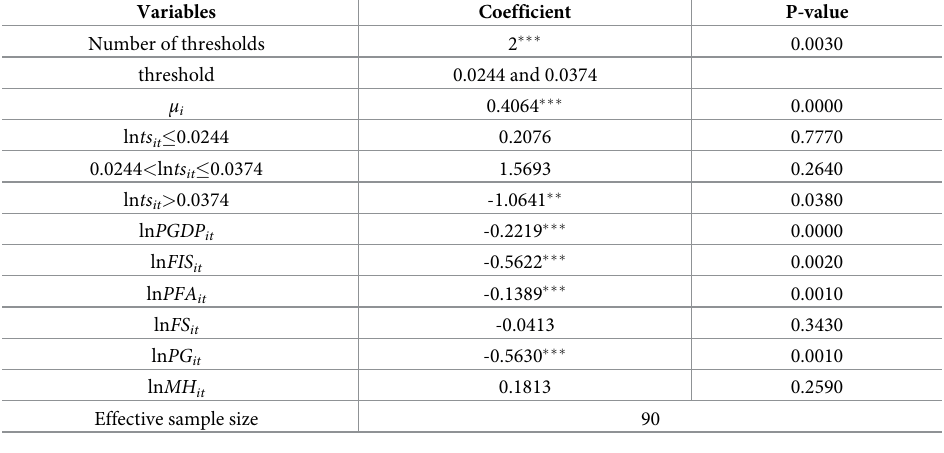
Table 6. Estimation results of panel threshold model parameters with core explanatory variables lagging behind one